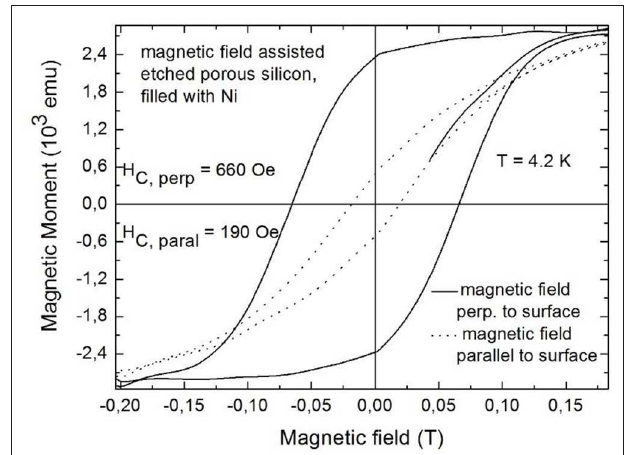
FIGURE 14 | Magnetic field dependent measurements performed with an external field applied perpendicular (solid line) and parallel (dotted line) to the sample surface. Granitzer et al. [94], AIP with